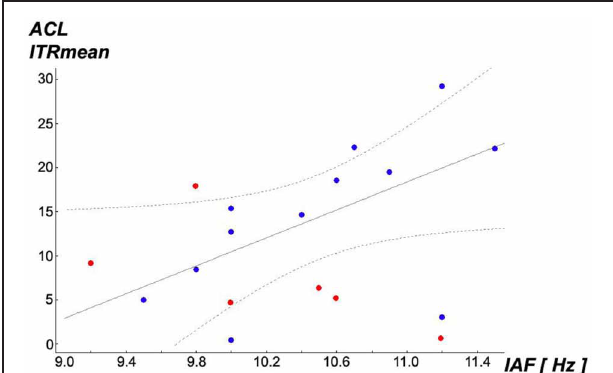
FIGURE 8 | Scatterplot of individual alpha frequency (IAF) vs. ITR Mean under condition (i) ACL algorithm (best-fit regression line for N = 12 as continuous line, 95% confidence regression bands as dotted lines). A significant Pearson correlation with r = 0 . 577, p = 0 . 0496 was found in the remaining subsample of N = 12 (blue points), removing subjects with N Trials < 25th percentile (8 . 75 ≈ 9) (red points), while over the entire sample of N = 18 the correlation is hidden with r = 0 . 282, p = 0 . 257 (all points). This relationship seems to exist exclusively for condition (i) ACL algorithm : the higher subjects’ IAF are in this subsample, the better will be their ITR Mean performance exclusively under (i). Partial correlation analyses confirmed that this association is linearly independent against